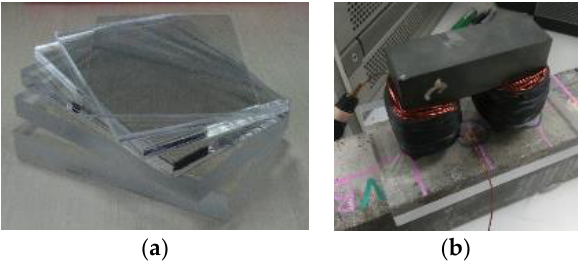
Figure 4. ( a ) Acrylic plates used in the experiment and ( b ) experiment set up of an effective depth test.